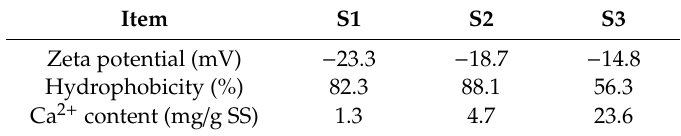
Table 2. Zeta potential, hydrophobicity, and Ca 2 + content for membrane foulants at di ff erent stages.